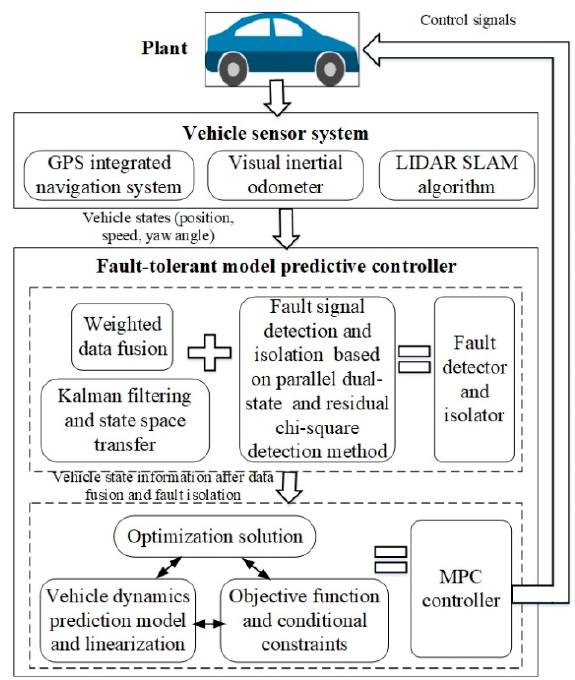
Figure 1. The flowchart of the fault-tolerant model predictive control algorithm.